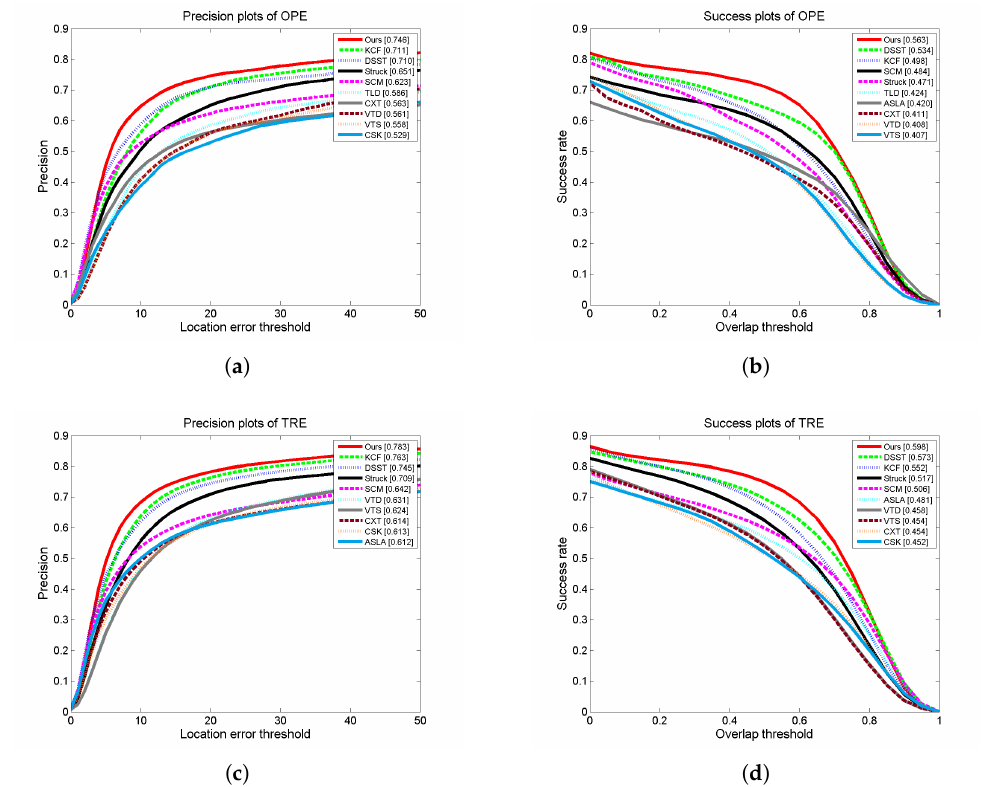
Figure 4. Quantitative results of the top 10 trackers on TB-50. ( a ) Distance precision based on OPE; ( b ) Success rate based on OPE; ( c ) Distance precision based on TRE; ( d ) Success rate based on